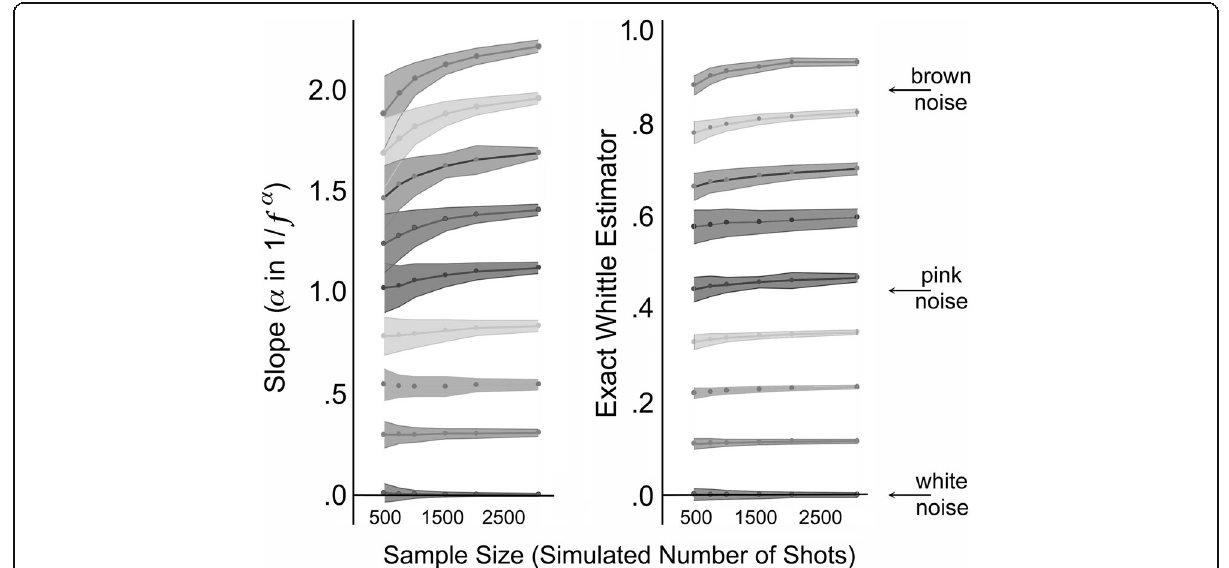
Fig. 5 Results of Study 3 investigating the relation between length of vectors and their fractal dimension. The panels show means (as points) and standard deviations (not confidence intervals) as shaded areas of noise simulations. Each point represents the mean of 1000 simulation trials. Noises were generated by algorithm (Little et al., 2007) and fit by the models used in Study 1 (measuring slope) and in Study 2 (measuring Whittle estimators by the method of Shimotsu & Phillips, 2005). In each panel, noises were generated with intended slopes of 0.0 to 2.0 in intervals of 0.25. Whittle values average about 43% of slope values in these